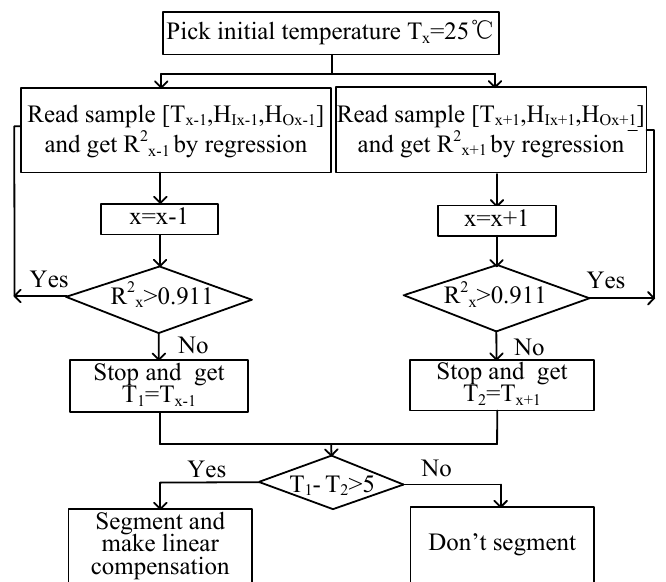
Figure 4. Flow chart of searching segmentation point.